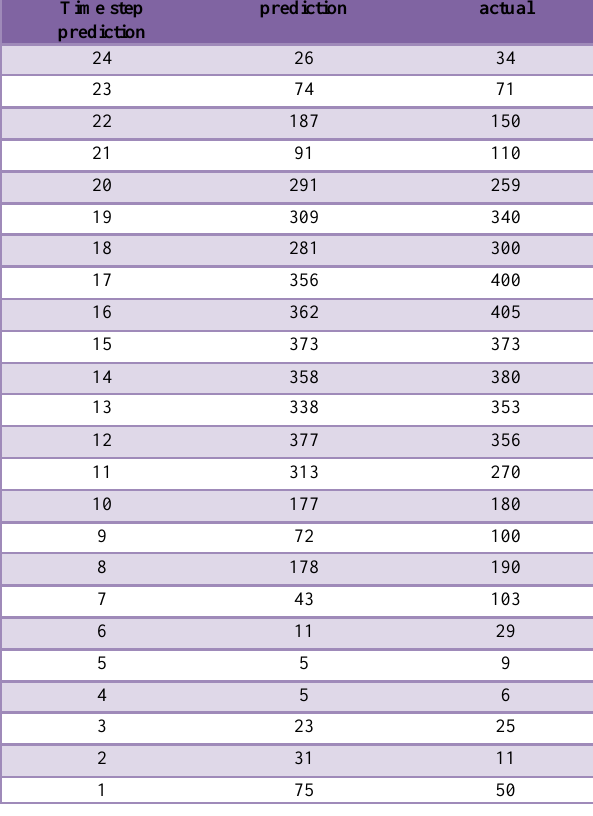
Table 1. Prediction for 24 hours of the 361st